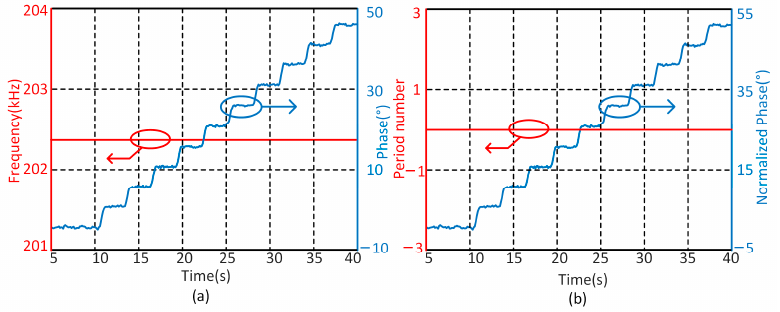
Figure 5. The system delay with a fixed FTD.